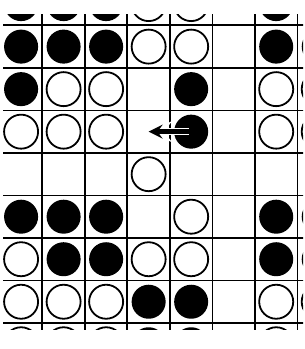
Figure 13. BLACK intrudes.